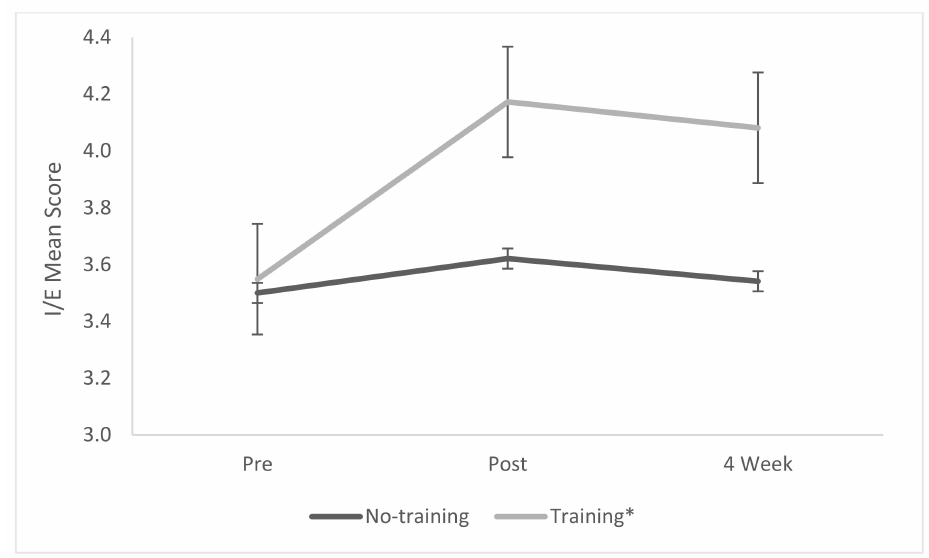
Figure 2. Mean scores for the Intrinsic Motivation Inventory subscale interest and enjoyment. * Statistically significant result.